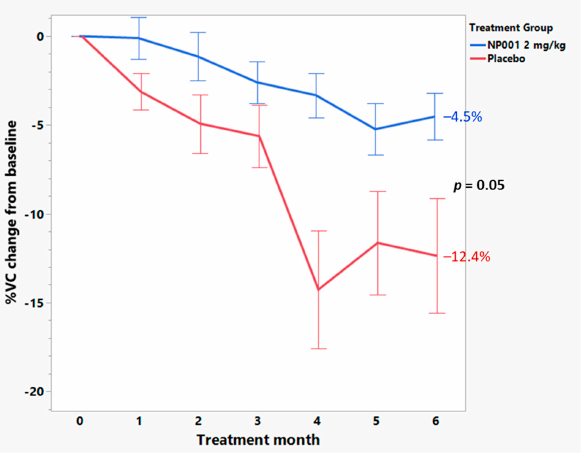
Figure 6. Among those aged ≤ 65 years with high baseline CRP, participants treated with NP001 experienced a slower vital capacity (VC) loss compared to placebo. %VC change from baseline for participants treated with NP001 ( n = 16) is depicted in blue and is compared to the placebo group ( n = 18) depicted in red. Error bars represent the range, mean ± SEM (standard error of the mean) of %VC change from baseline. The NP001 treatment group showed a 64% slower VC loss by the end of study (Wilcoxon test, p = 0.05).